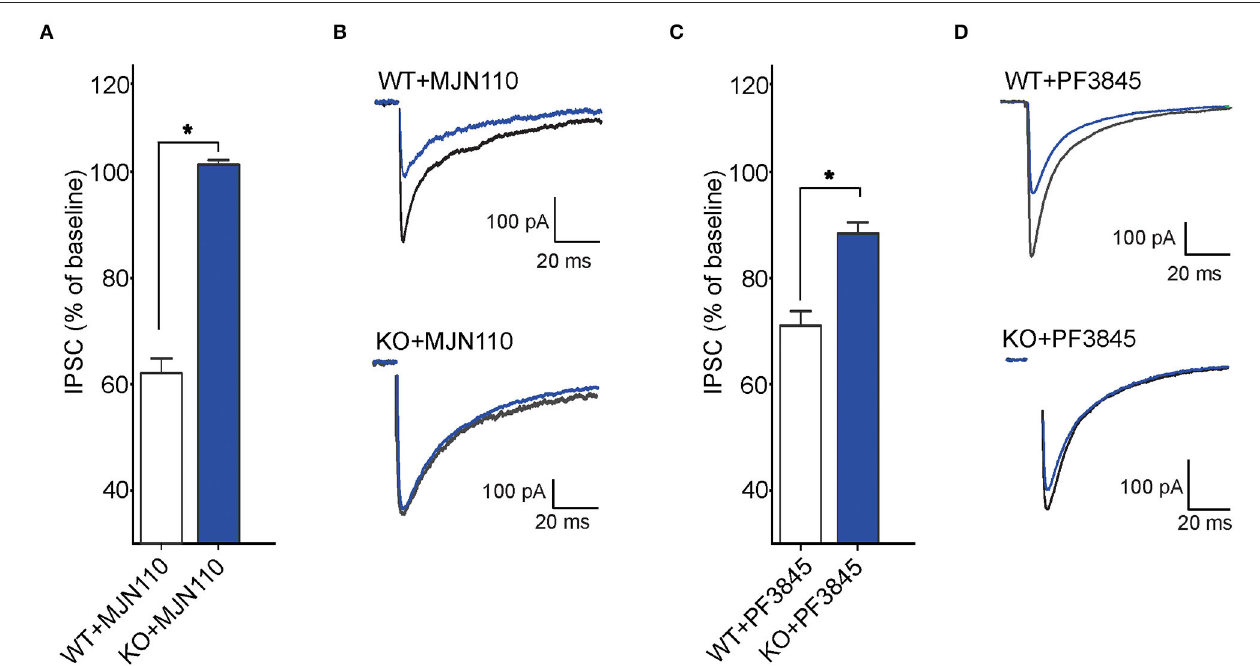
FIGURE 6 | FABP5 deletion impairs tonic 2-AG and AEA signaling at striatal GABA synapses. (A) The average depression of eIPSC induced by the MAGL inhibitor MJN110 (10 µ M) in WT and FABP5 KO mice. Average reduction in the amplitude of eIPSCs to baseline, in WT (WT + MJN110: 62.01 ± 1.10%, n = 5 cells from 5 mice, t4 = 17.83, p < 0.05, vs. baseline) and FABP5 KO (KO + MJN110: 101.36 ± 0.32 %, n = 5 cells from 5 mice, t4 = − 0.52, p > 0.05, vs. baseline) slices during bath application of MAGL inhibitor. (B) Sample eIPSC traces taken before and during MJN110 application in WT (top) and FABP5 KO mice (bottom). Note that FABP5 deletion prevents the depression of eIPSCs induced by MJN110. (C) Average reduction of eIPSC induced by the FAAH inhibitor PF3845 (3 µ M) in WT (WT + PF3845: 71.14 ± 1.16%, n = 5 cells from five mice, t4 = 18.49, p < 0.05 vs. baseline) and FABP5 KO (KO + PF3845: 88.52 ± 0.74 %, n = 5 cells from 5 mice, t4 = 5.10, p < 0.05, vs. baseline) slices. (D) Representative eIPSC traces before and during PF3845 application in WT and FABP5 KO mice. *, p <